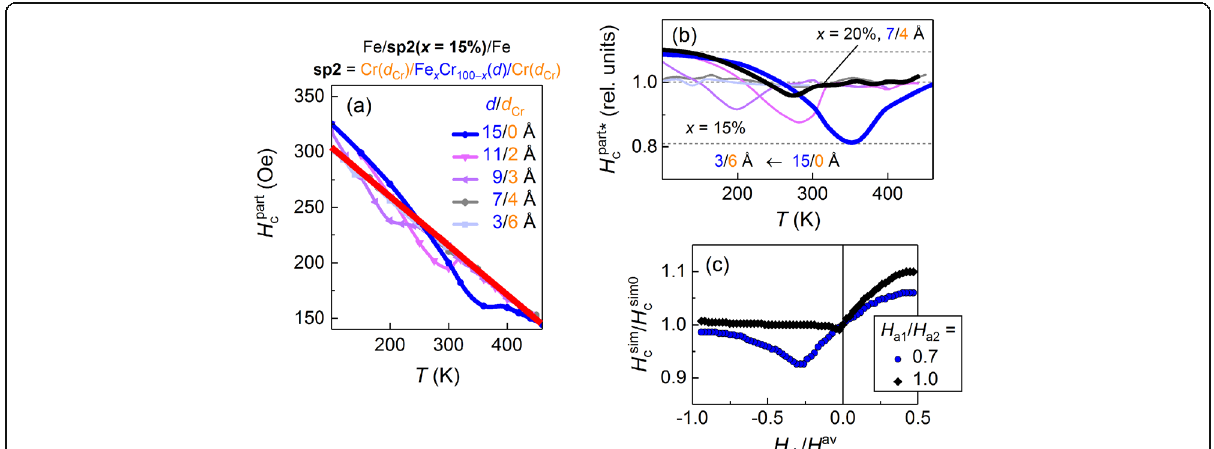
Fig. 5 a Temperature dependence of coercivity of partial loops ( H c part ) for structures Fe/sp2( x =15%)/Fe with different thickness of Fe x Cr 100 − x and Cr layers ( d and d Cr , respectively) in spacer sp2. Red thick line is linear approximation of high-temperature part of H cpart ( T ). b Temperature dependence of coercivity normalized to linear background. c Coercivity vs. H J obtained from simulated M ( H ) curves for two cases: (1) H a1 / H a2 =0.7 and (2) H a1 = H